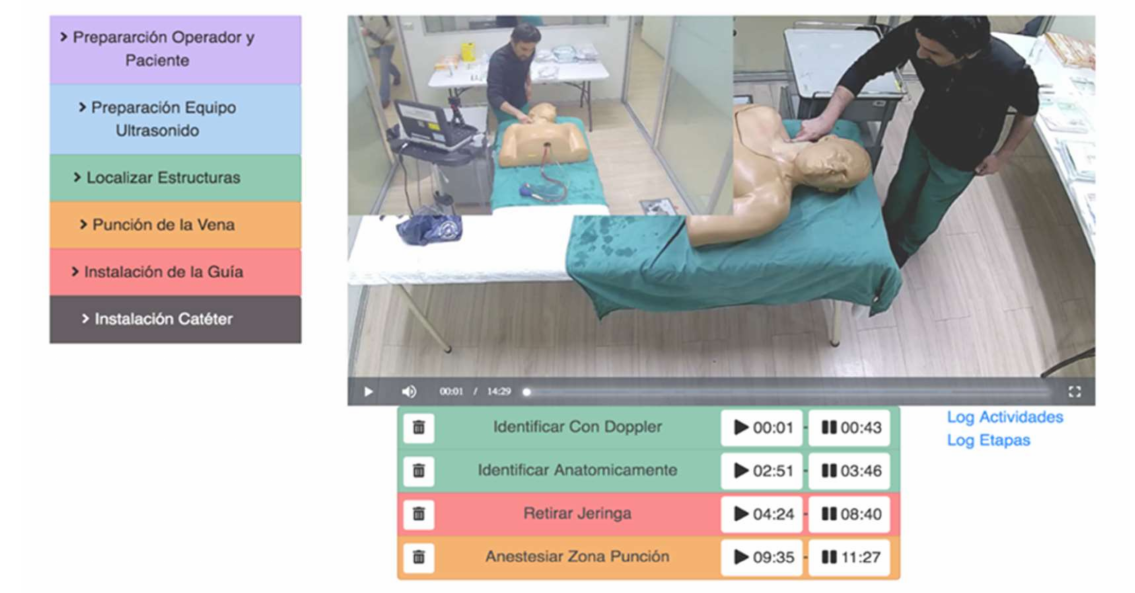
Figure 2. Sample video tagging.